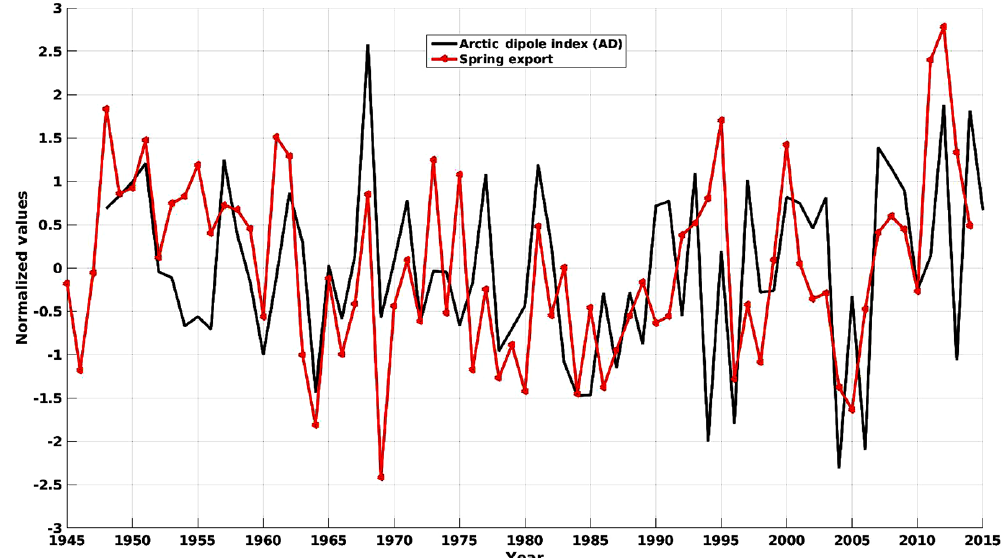
Figure 8. Fram Strait spring export (March–August) and April–July Arctic dipole (NCEP/NCAR reanalysis) anomalies from 1948 to 2014. Both time series are detrended and normalized by their standard deviations, 0.817 millionkm 2 and 28.8hPa, respectively. The correlation between them is r AD-FS ice export = 0 . 45 for the entire period and similar for 1979–2014 (r AD-FS ice export = 0 . 44 )